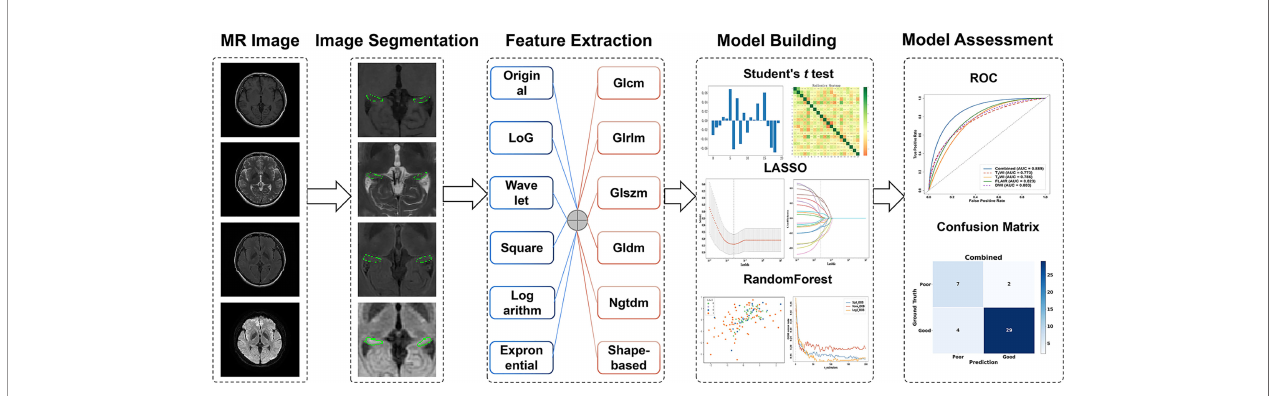
FIGURE 2 | Radiomics work fl ow in the